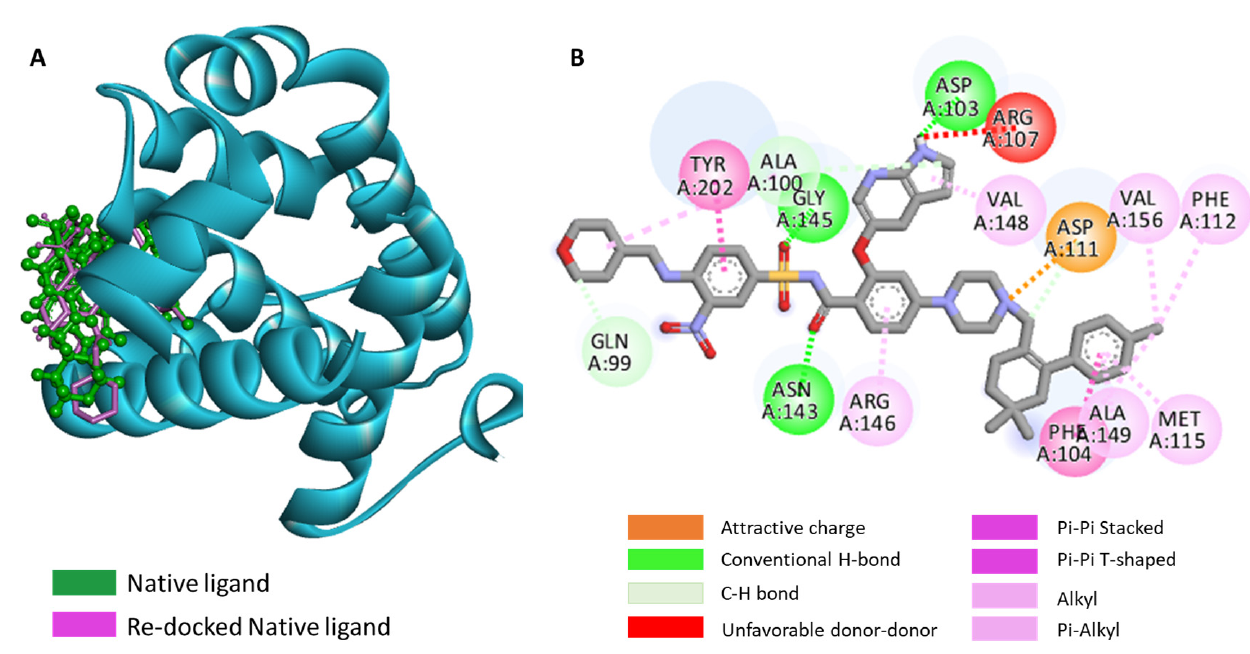
Figure 3. ( A ). The 3D binding mode of the re-docked ligand (purple, sphere and stick) within the binding pocket of BCL2 (PDB ID: 6O0K). It is shown to be superimposed on the same position as the original ligand (green, ball and stick), with the same orientation. ( B ). The 2D binding mode of the re-docked ligand LBM within the binding pocket of BCL2 (PDB: